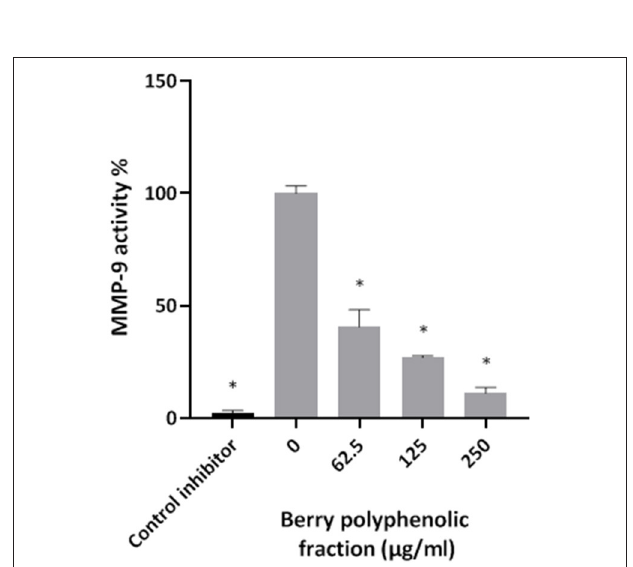
FIGURE 6 | Effect of the berry polyphenolic fraction on MMP-9 activity. N-isobutyl-N-[4-methoxyphenylsulfonyl]glycyl hydroxamic acid was used as a control inhibitor. A relative value of 100% was assigned to the activity in the absence of the berry polyphenolic fraction. Results are expressed as the means ± SD of triplicate assays from three independent experiments. *Significant inhibition ( p < 0.01) compared to the control.